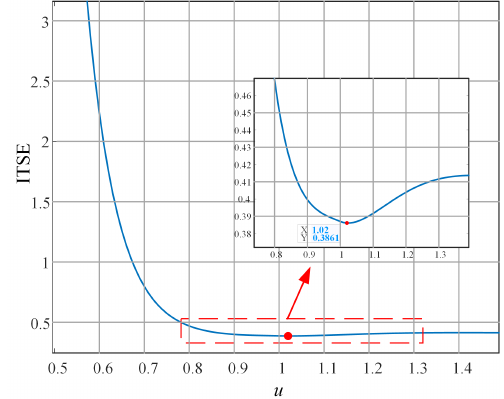
Figure 4. J ITSE of FOIC corresponding to u